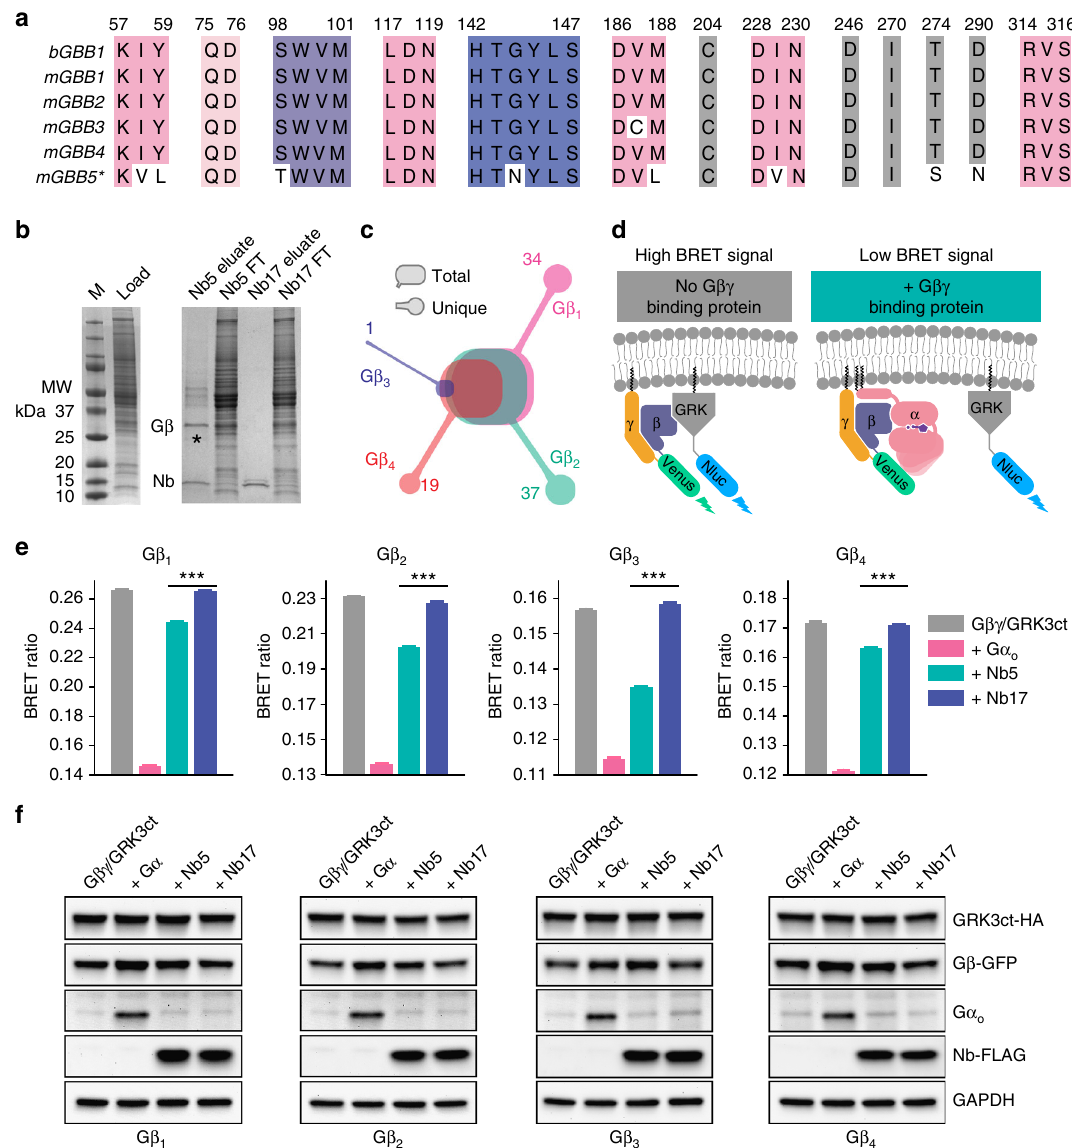
Fig. 4 G β selectivity of Nb5. a Multiple sequence alignment of key amino acid residues of G β that interact with Nb5. *The amino acid numbering of G β 5 has an off-set of − 50. b Nb5-mediated G βγ extraction from mouse brain. Solubilized and partially puri fi ed extracts from mouse brain (left) were subjected to either Nb5- (right, lanes 1 and 2) or Nb17- (right, lanes 3 and 4) mediated immobilized-metal af fi nity puri fi cation of G βγ . c In-gel protein digestion of G β subtypes (band marked in b with asterisks) puri fi ed from mouse brain. Peptides were separated, analyzed and searched against a full mouse proteome to identify unique peptides from G β 1 , G β 2 , G β 3 , and G β 4 . d Schematic diagram of the effect of G βγ -binding proteins on the BRET assay. Co-transfection of HEK293T/17 cells with Venus-G βγ and masGRK3ct-Nluc-HA produced a high BRET signal through their direct interaction (left). Introduction of G βγ - binding proteins (e.g., the G α subunit) competed with masGRK3ct-Nluc-HA, lowering the BRET signal (right). e Effects of Nb5 on the interaction of G βγ and the C-terminus of GRK3. The maximum BRET signal was determined by co-transfection of different Venus-G β subtypes + G γ 2 pairs and masGRK3ct-Nluc- HA (grey). A minimum BRET signal also was determined after co-transfection of Venus-G β 1 γ 2 and masGRK3ct-Nluc-HA with an excess amount of G α oA (pink). Effects of Nb5 and Nb17 were examined by co-transfection of Venus-G βγ and masGRK3ct-Nluc-HA with either Nb5 (greencyan) or Nb17 (purple). Experiments were performed with G β subtypes 1 – 4 + G γ 2 pairs. Each bar represents the mean of six replicates. Similar results were obtained in three independent experiments. Results are expressed as the mean ± SEM. One-way ANOVA with Tukey ’ s post hoc multiple comparison test relative to the G β 1 γ 2 /GRK3ct control, *** P ≤ 0.001, n = 6 replicates. f Western blot quanti fi cation of the expression levels of G β 1 – 4, GRK3, G α , Nb5, and Nb17 (Full